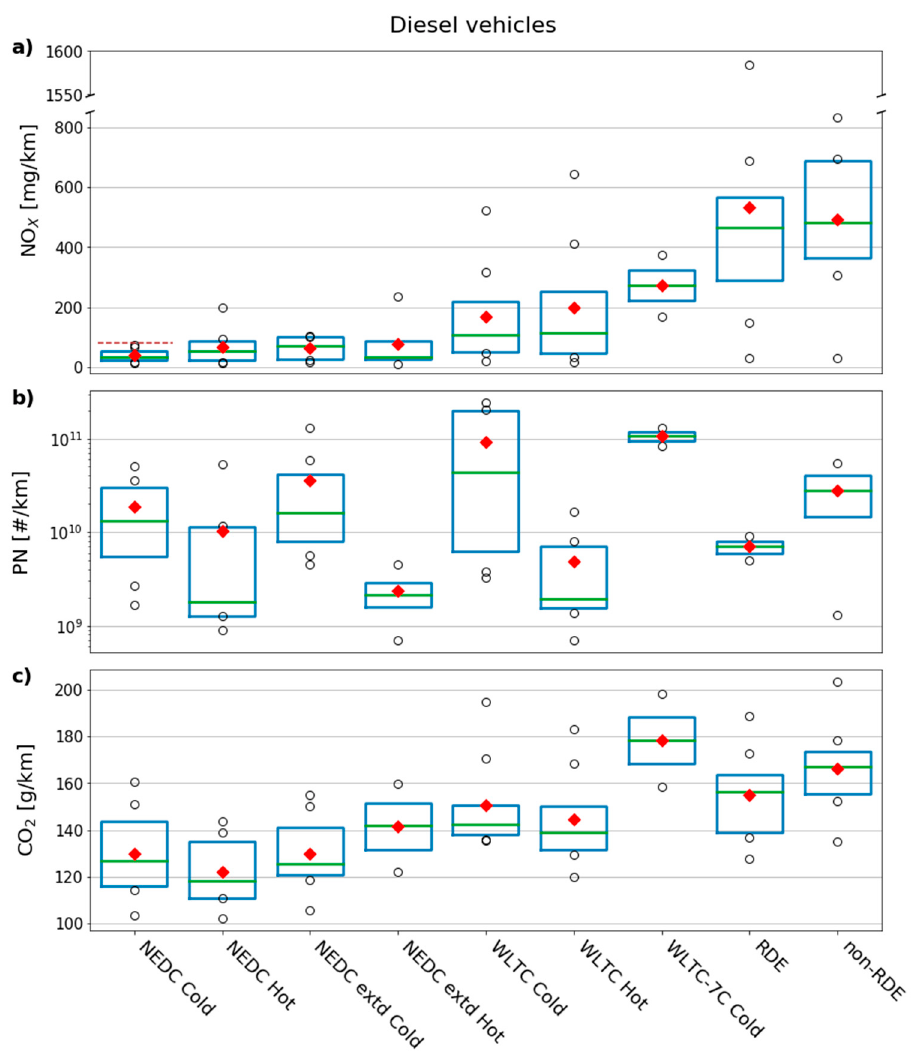
Figure 1. Boxplot of emission factors of the diesel sample for complete tests ( a ) NO X [mg / km], ( b ) particle number (PN) [# / km], and ( c ) CO 2 [g / km]. The box represents the 1st and 3rd quartile, the green line is the median, the red diamond is the mean, and the black circles are data points beyond the interquartile range. In ( a ) the brown dashed line represents the Euro 6 emission limit at type approval for diesel vehicles over the NEDC cold test [80 mg / km] (PN limit of 6 × 10 11 # / km not displayed for readability). Note that in ( a ) the y -axis is broken in two sections, and in ( b ) y -axis is logarithmic.